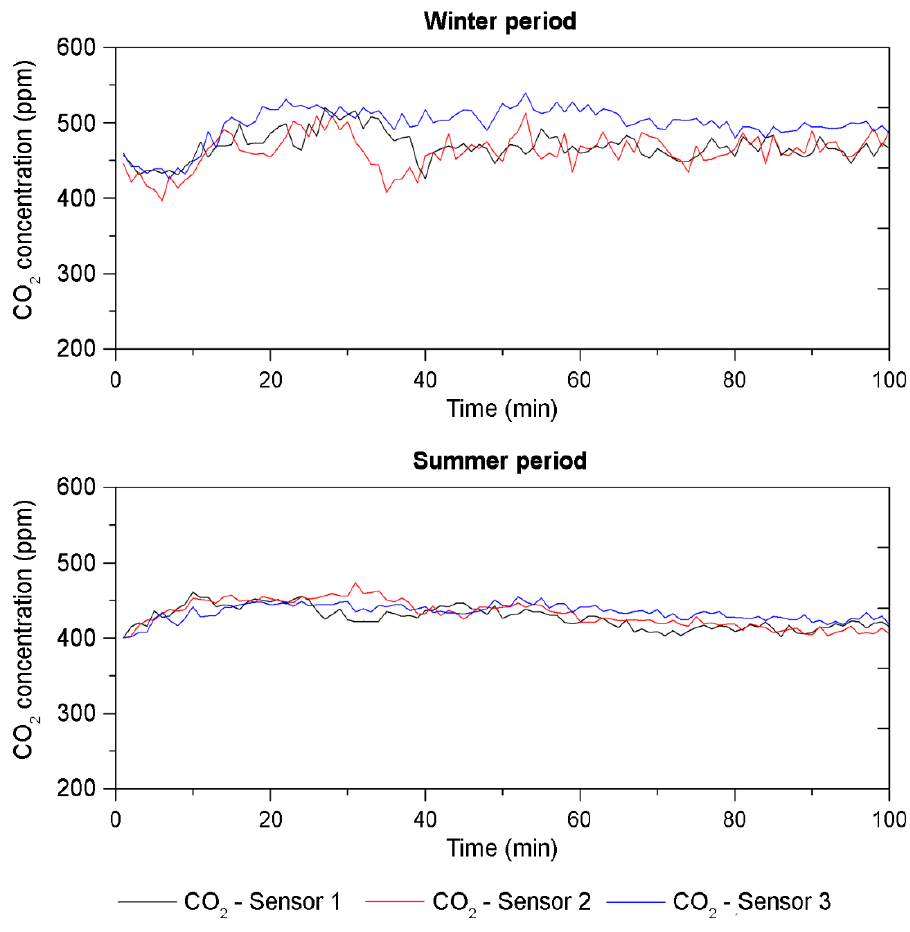
Figure 6. CO 2 concentration data obtained in both assessment